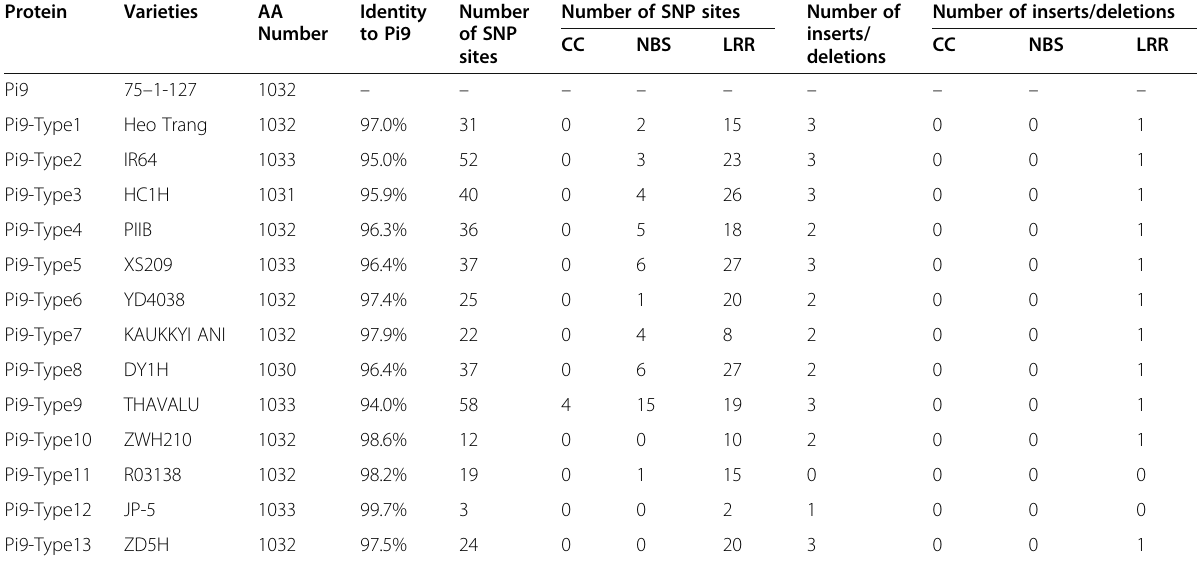
Table 3 Summary of difference in each alleles of the Pi9 protein Protein Varieties